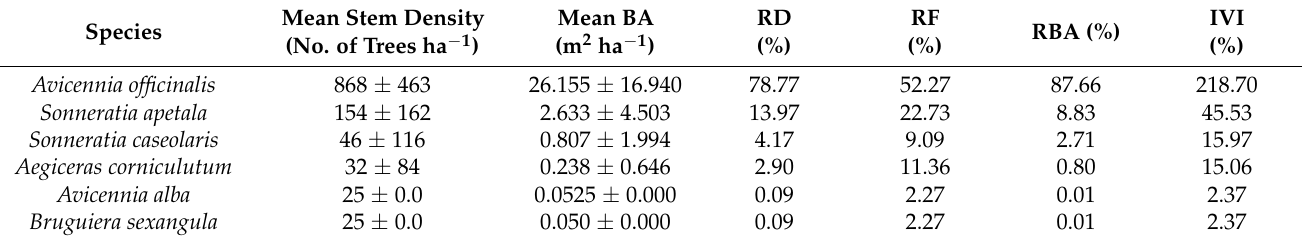
Table 2. Tree species found in the mangrove stand of LetKhutKon Village (mean ±